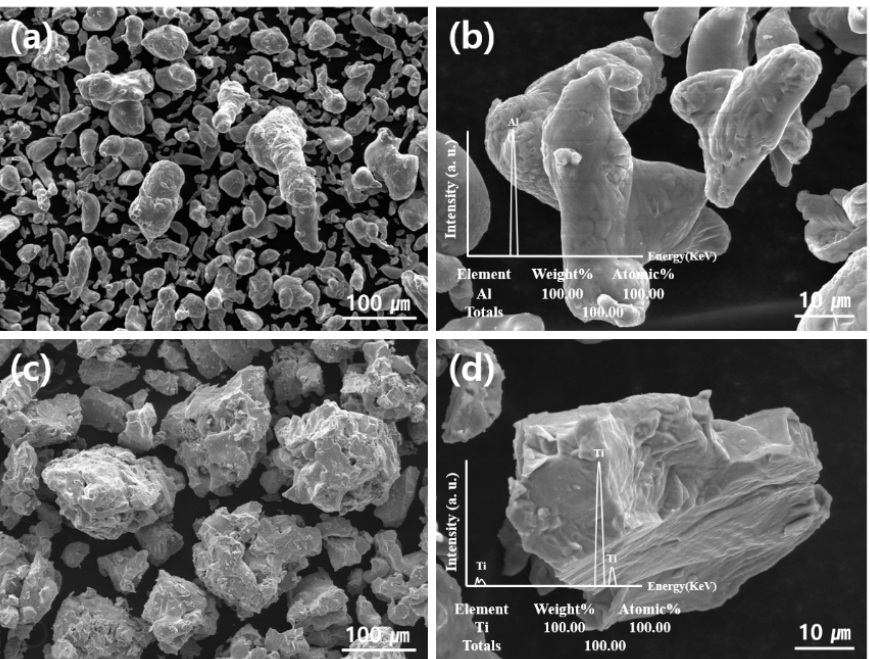
Figure 2. Scanning electron microscopy (SEM) images of ( a ) and ( b ) pure Al powder, and ( c ) and ( d ) pure Ti. Energy dispersive spectroscopy (EDS) spectra of pure Al and pure Ti powders are included in the insets of ( b ) and ( d ).